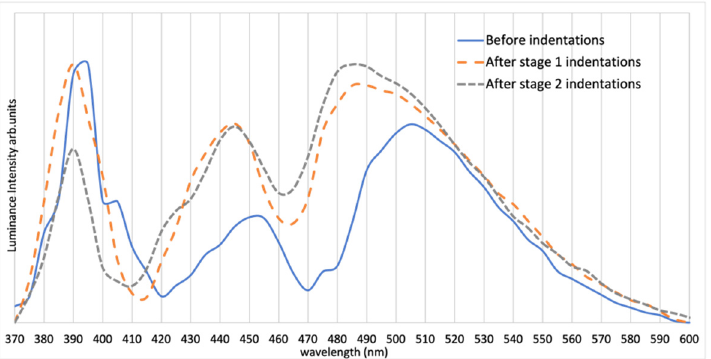
Figure 5. Spectrum of Sample 2 before and after indentation at each stage (normalized at highest peak).